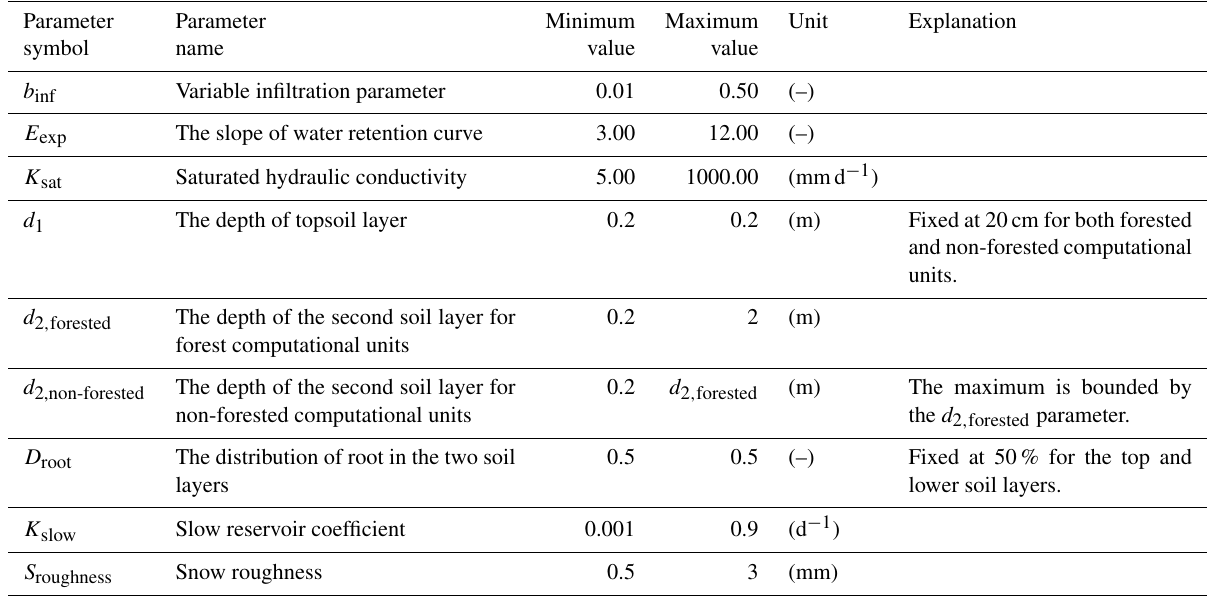
Table 1. The VIC model parameters that are subject to perturbation for model calibration for the designed experiments. Parameter